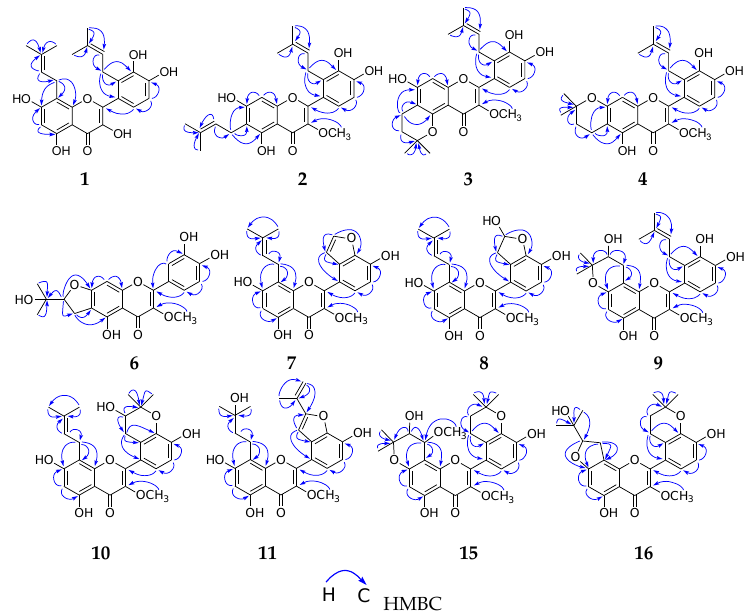
Figure 2. Key HMBC correlations of compounds 1 – 4 , 6 – 11 , 15 , 16.